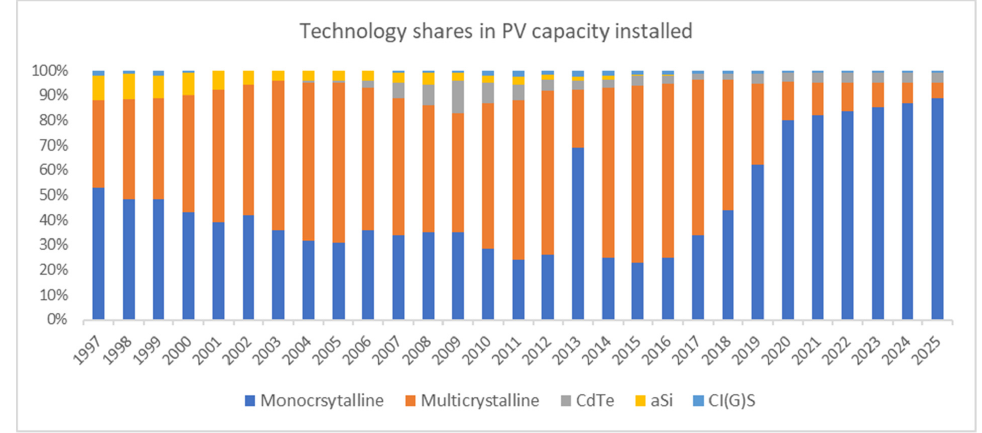
Figure 5. Shares of PV technologies between 1997–2025.